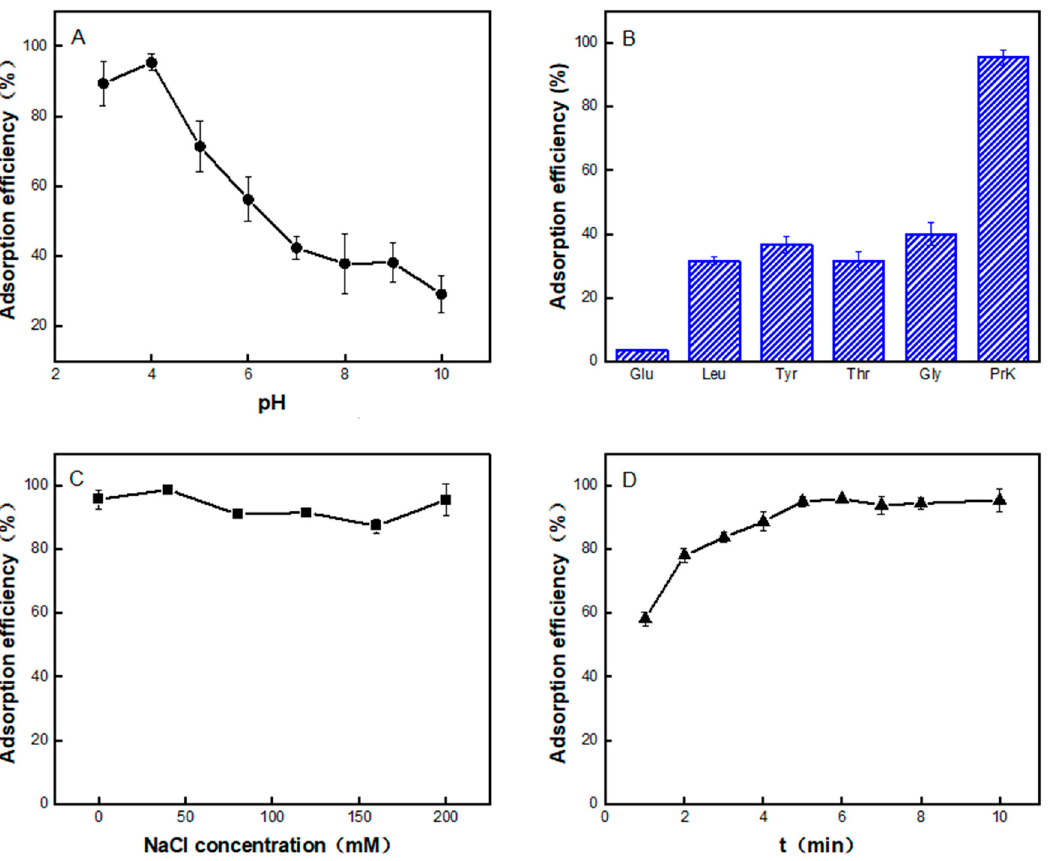
Figure 3. ( A ) Effect of pH on PrK adsorption efficiency. ( B ) Adsorption efficiency of Glu, Leu, Tyr, Thr, Gly, and PrK on Co 4 PW–PDDVAC composite. Effect of ionic ( C ) strength and ( D ) adsorption time on PrK adsorption efficiency. Protein solution: 100 μ g mL − 1 , 1.0 mL; Co 4 PW–PDDVAC composite: 0.2 mg; pH: 4.0.